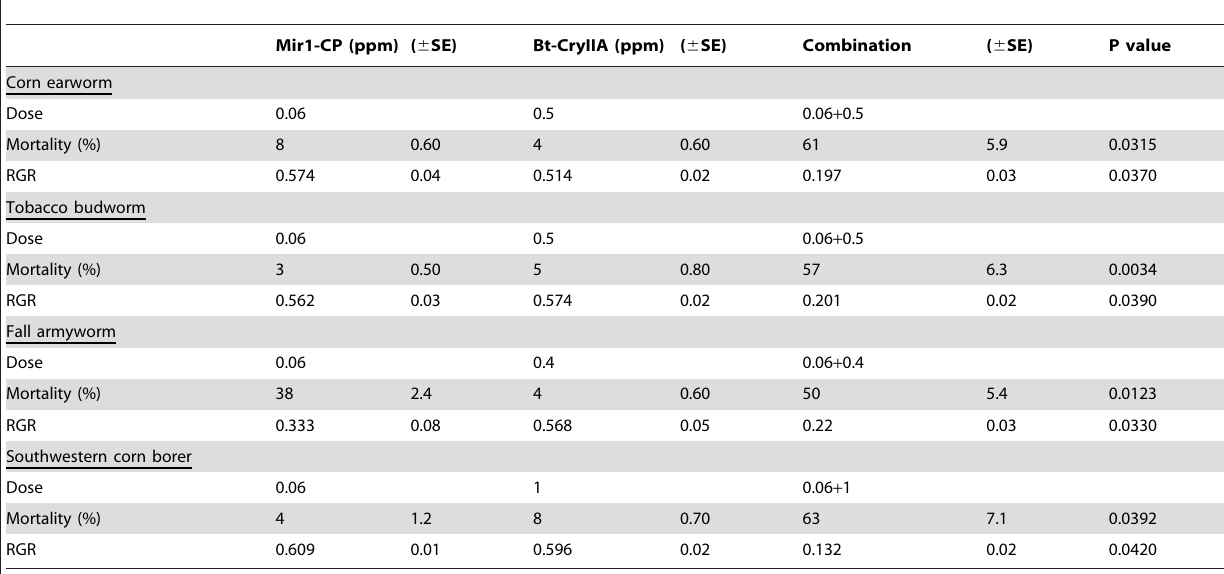
Table 2. Relative growth rate (RGR) and percentage mortality of Lepidopteran larvae fed on Mir1-CP, Bt-CryIIA or Mir1-CP and Bt- CryIIA in combination.